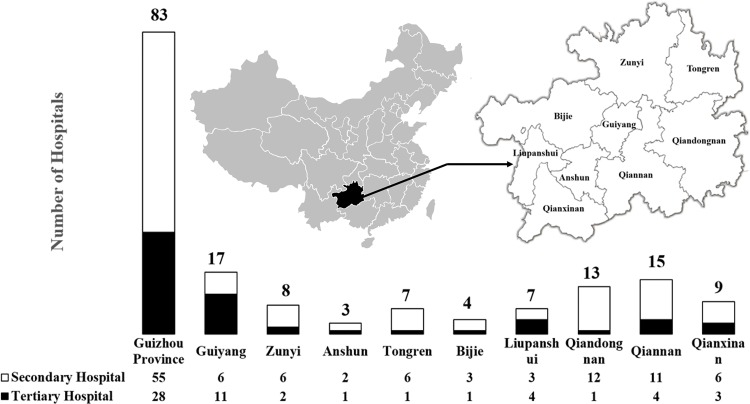
The characteristics of included hospitals.